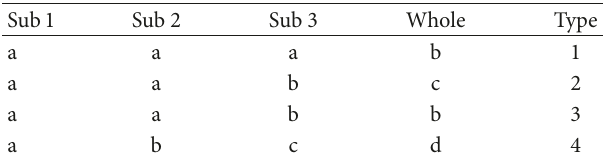
Table 3: Illustration of 4 emergence